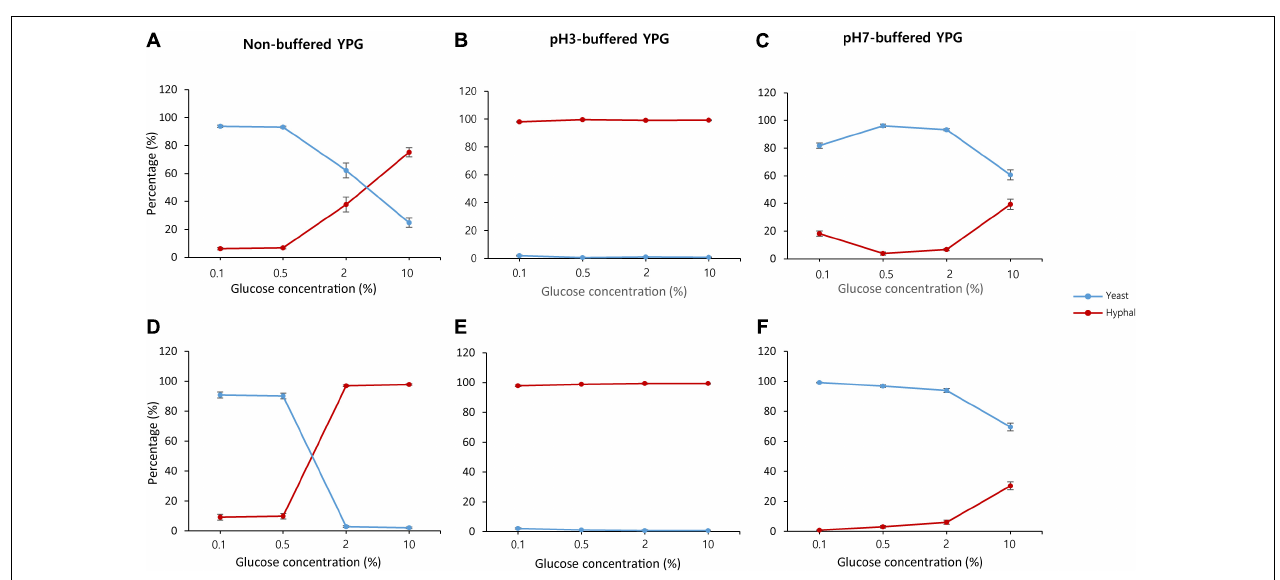
FIGURE 1 | Yeast-to-hyphae transition of Saccharomycopsis fibuligera at acidic pH values. KPH12 strain (A,B) and KJJ81 interspecies hybrid strain (C,D) were grown at the indicated pH values. (A,C) Percentage of yeast and mycelium in S. fibuligera grown in YPG broth buffered at pH 7, 6, 5, 4, 3 and incubated at 25 ◦ C for 20 h with shaking at 200 rpm. Blue, yeast percentage; Red, hyphae percentage. (B,D) Morphology and size of the cells at each pH value; scale bar = 4 µ m.